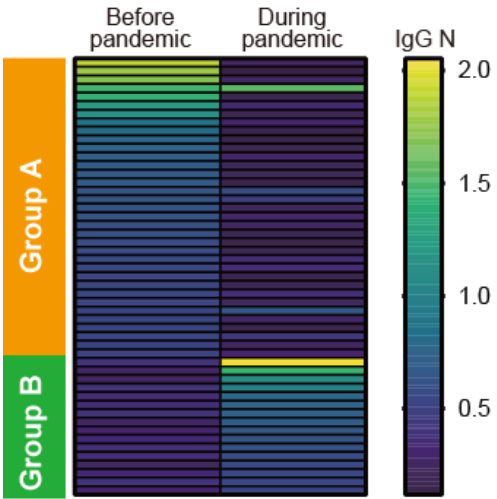
Figure 5. Heatmap images of IgG NC titers of serial serum samples from the same cases obtained before and during the COVID-19 pandemic ( n = 219). One hundred sixty-eight serum samples (76.7% of tested cases) had no IgG N before and in 2020 (not depicted here). A total of 32 of 35 patients that were positive for IgG N before 2020 became negative in 2020 (indicated as group A), whereas 16 of 184 patients that were negative for IgG N before 2020 became positive in 2020 (group B). Yellow and blue cells depict high and low IgG NC titers (OD values at 450 nm absorbance), respectively.